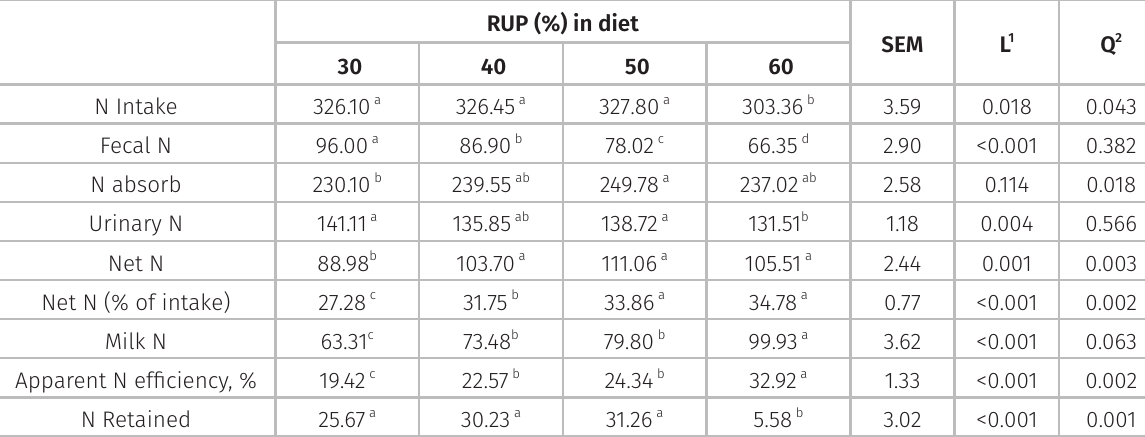
Table IV. Nitrogen balance (g/day) of cross bred (Friesian×Jersey) dairy cattle fed diets with various levels of rumen undegradable protein